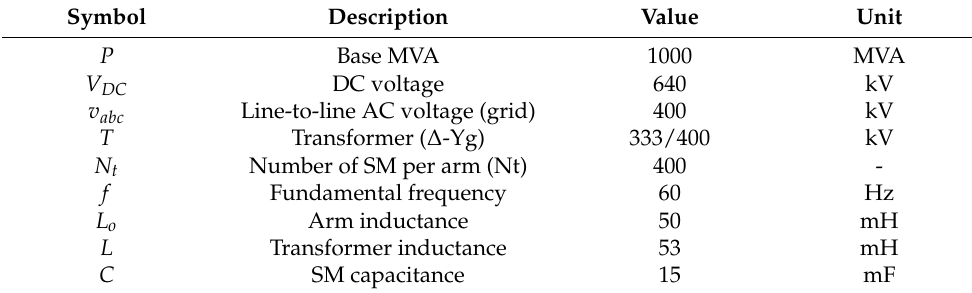
Table 1. Parameters of simulated MMC system.